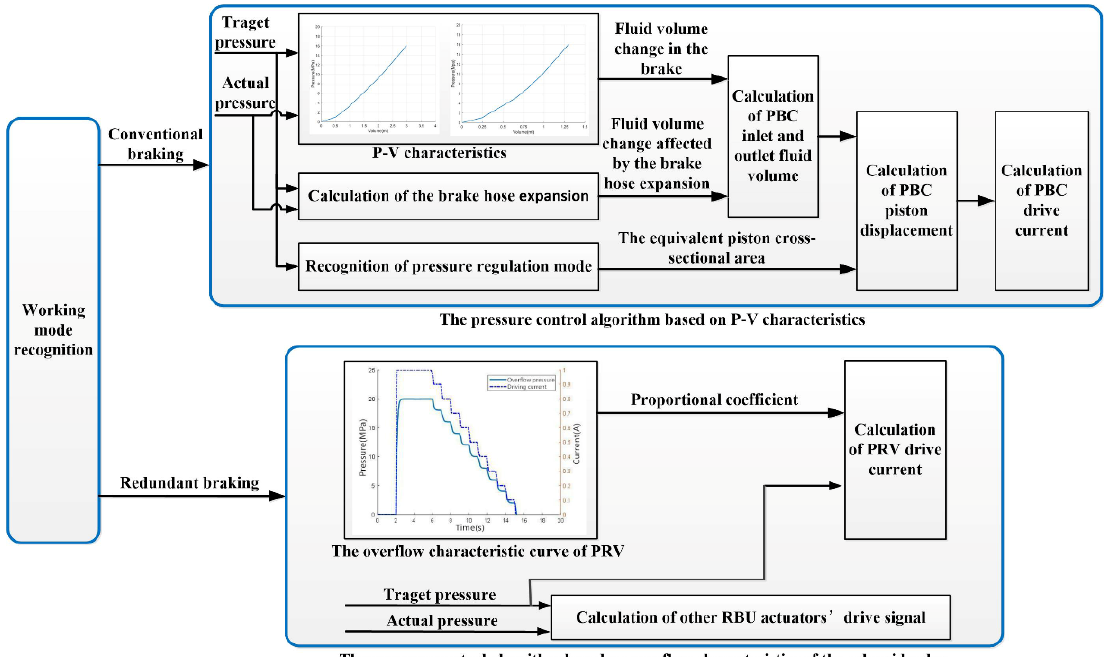
Figure 7. Schematic representation of the pressure control algorithm.